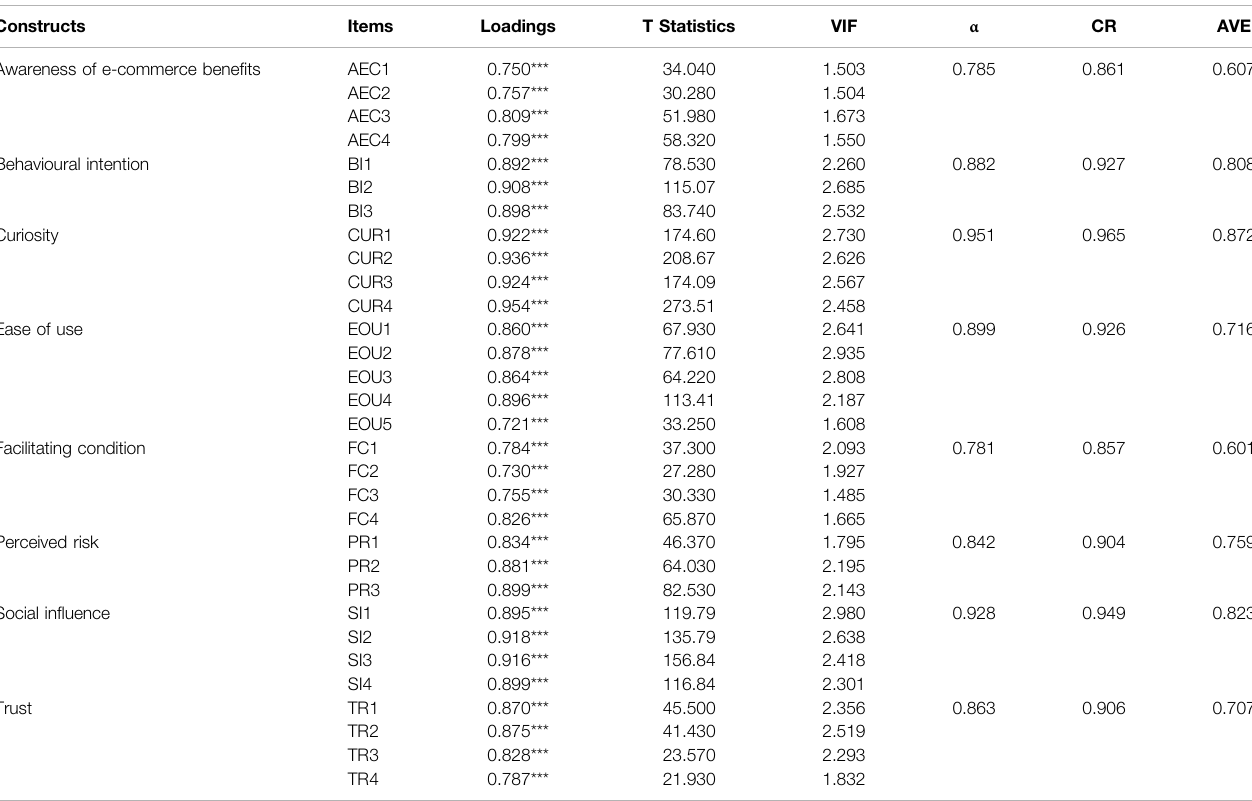
TABLE 2 | Reliability and validity